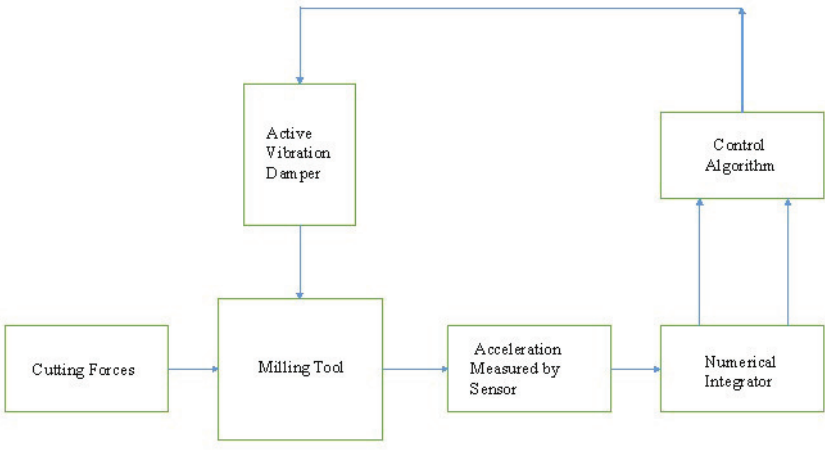
Figure 3. Brief overview of control